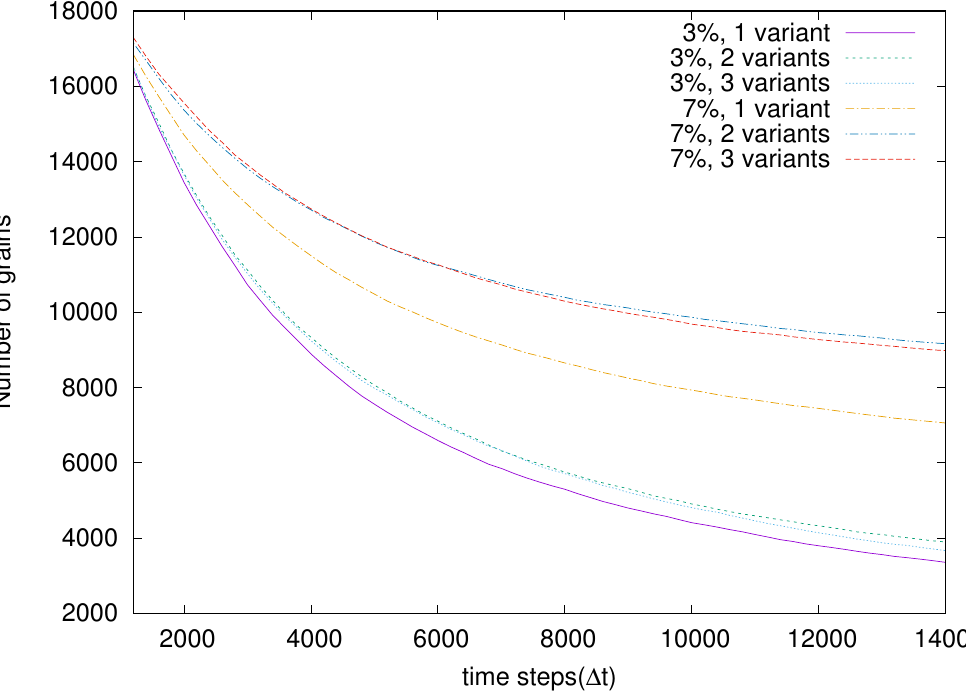
Figure 8. Number of grains with respect to time when 3 vol% hydrides 7 vol% hydrides are involved. We plotted the values for the cases of 1, 2 and 3 structural variants of the